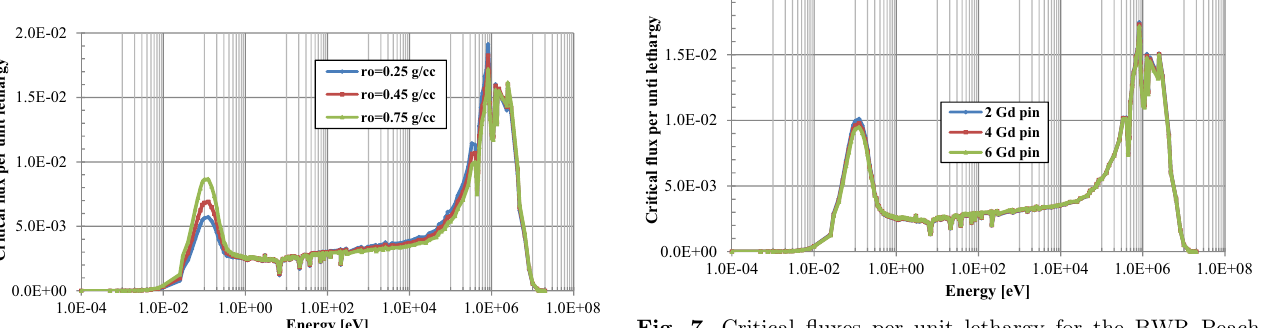
Fig. 7. Critical fl uxes per unit lethargy for the BWR Peach Bottom 7 (cid:3) 7 FA for 2, 4 and 6 gadolinium fuel